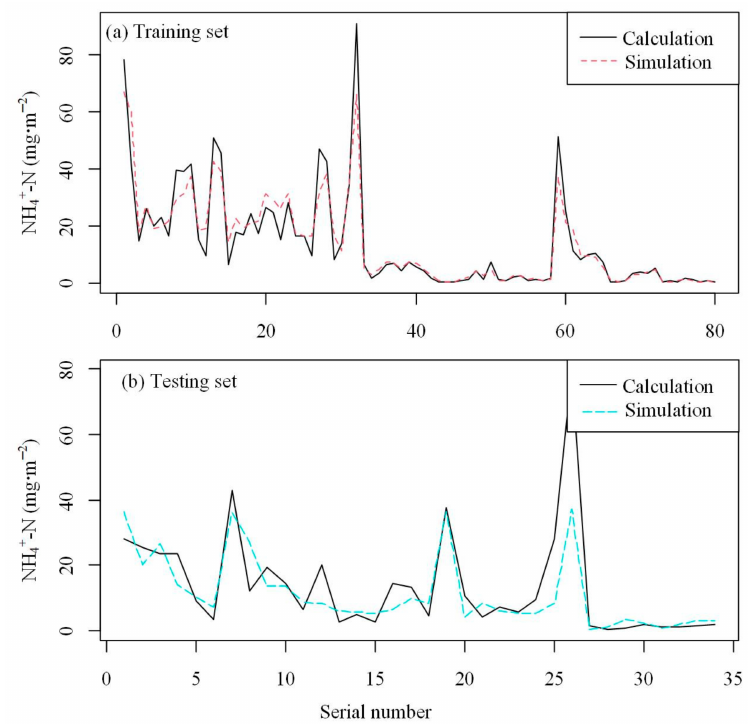
Figure 8. Calculated and simulated runoff NH 4 + -N loads of paddy fields based on